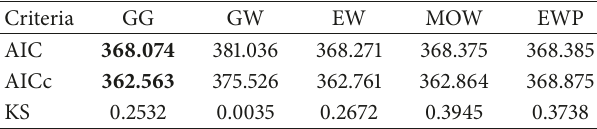
Table 12: Results of AIC and AICc criteria and the 𝑝 value from the KS test for all fitted distributions considering the transmission